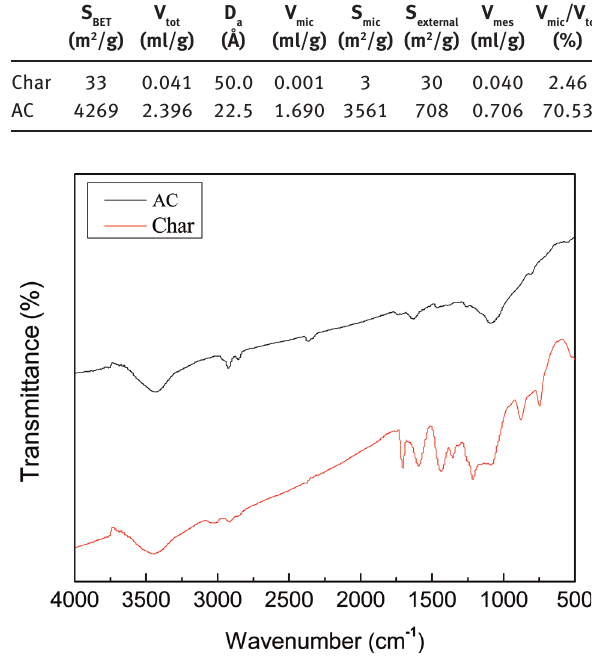
Figure 3: Fourier transform infrared spectroscopy (FTIR) spectra of the AC and